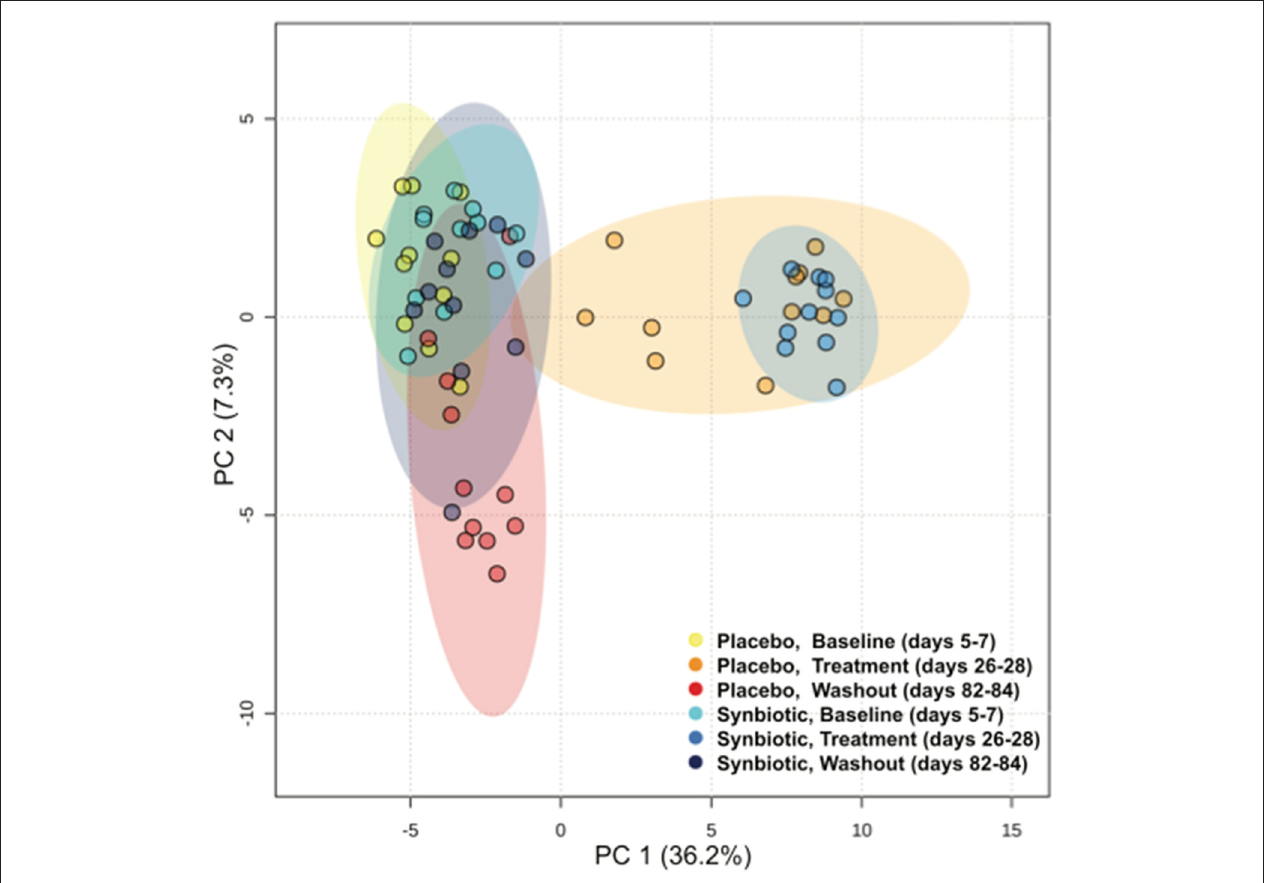
FIGURE 5 | Principal Component Analysis (PCA) of fecal metabolites for dogs that received enrofloxacin/metronidazole followed by placebo or synbiotic for 21